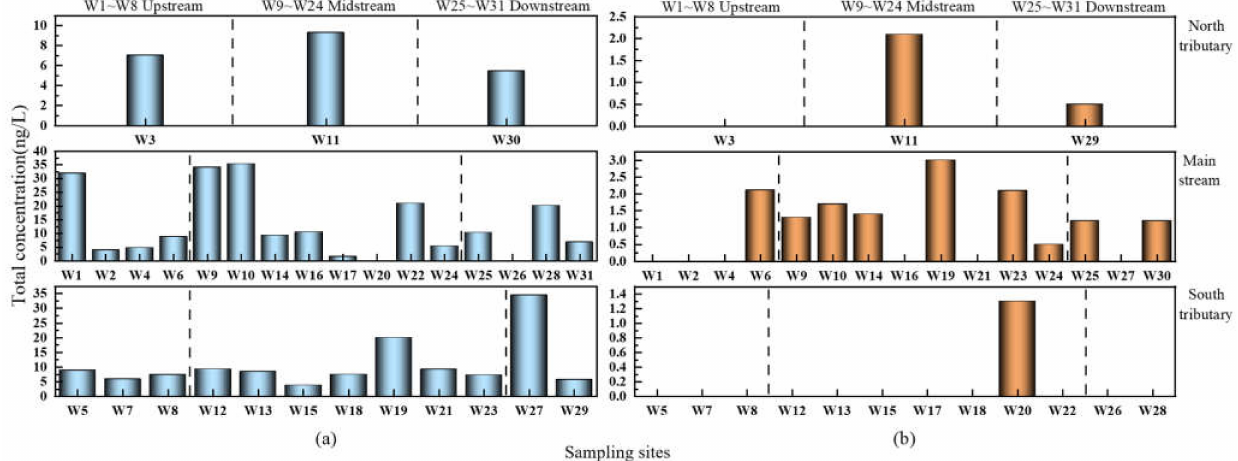
Figure 6. Distribution of SAs in the main steams and tributaries of the Weihe River: ( a ) the wet water period; ( b ) the flat water